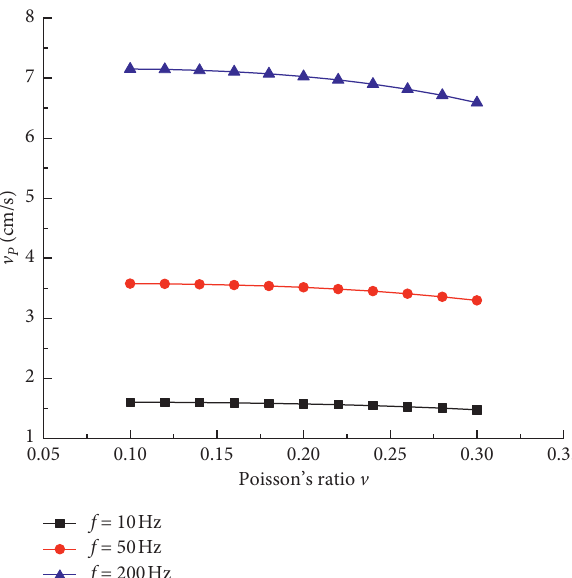
Figure 8: Variation of v E � 30GPa.